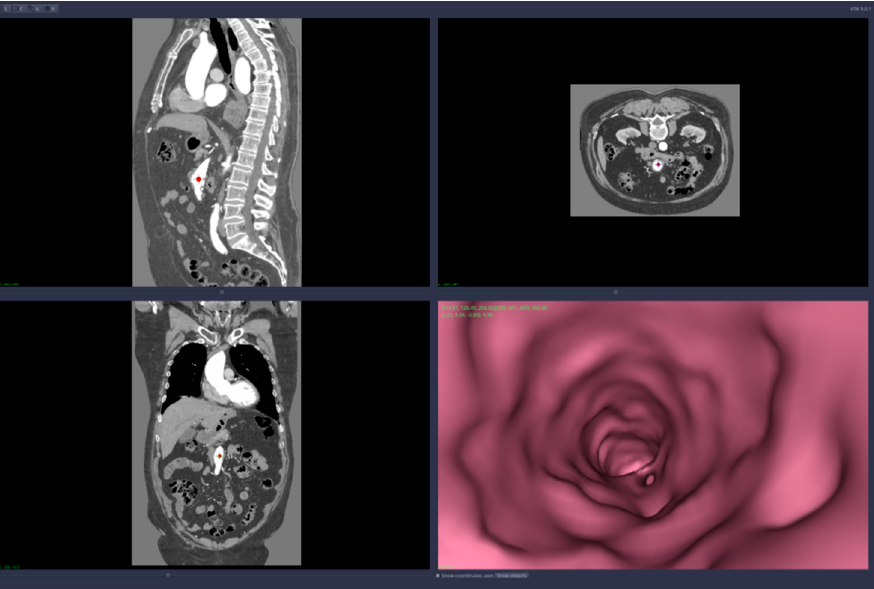
Figure 4. Virtual angiography—inside the mesenteric artery aneurysm (direction is opposite to the blood flow).